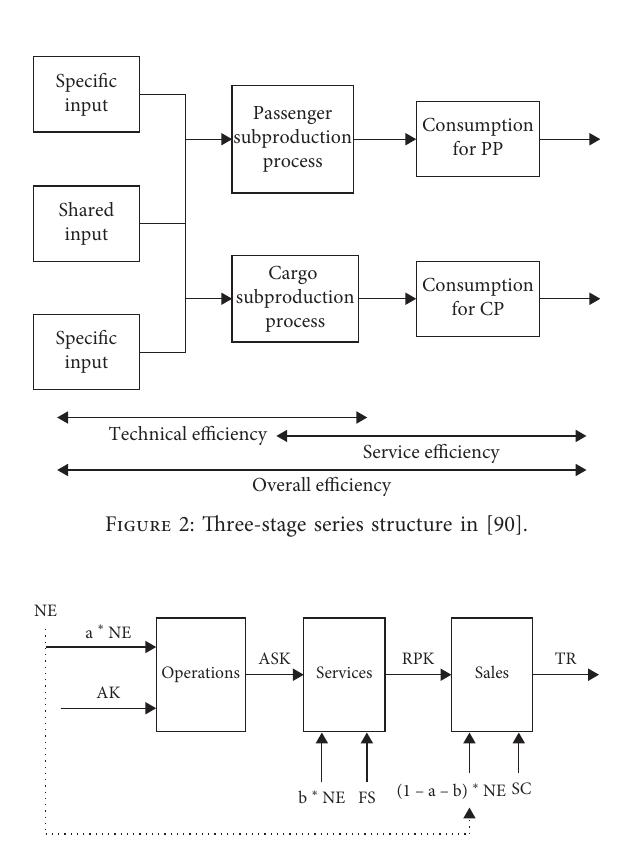
Figure 3: Dynamic structure in [58].